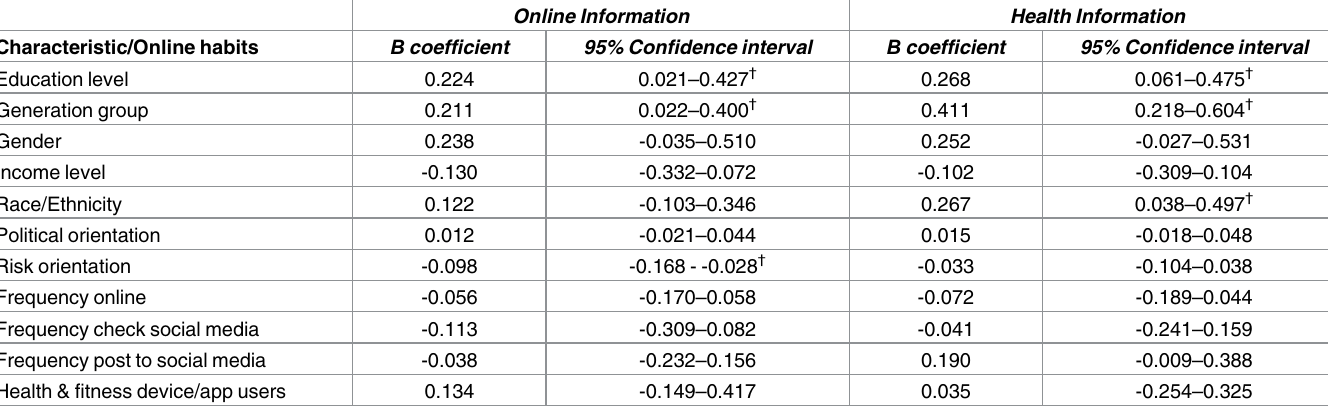
Table 2. Predictors of level of concern about privacy of online and health information * .